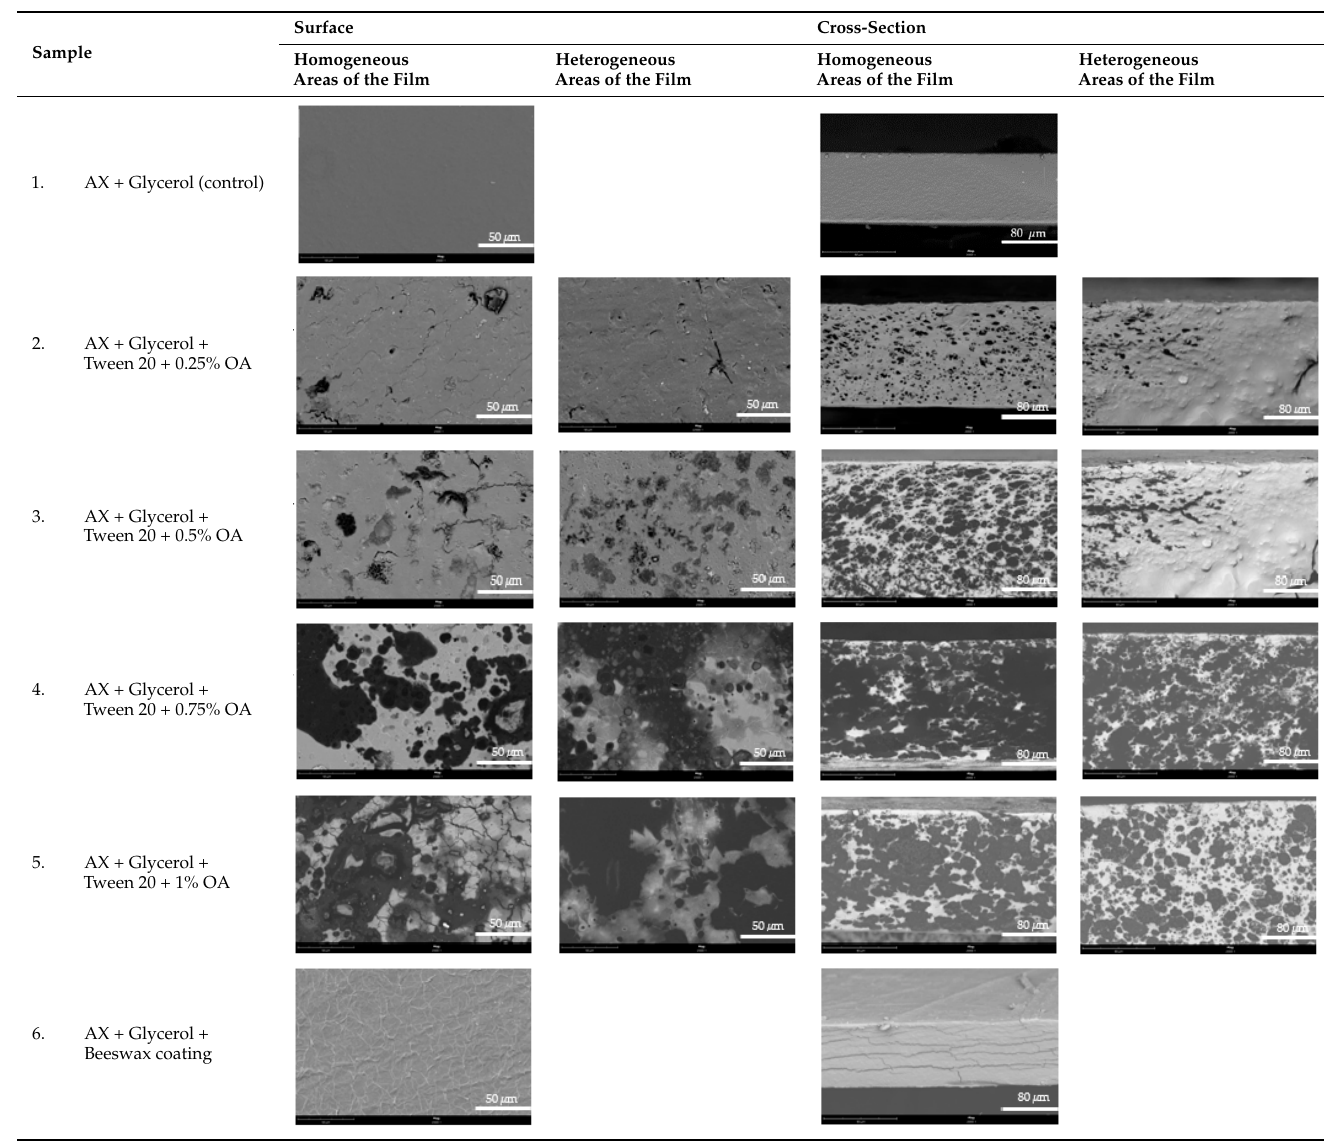
Table 4. Thicknesses of all the film samples. Values in the same column followed by different superscript letters differ significantly ( p < 0.05).